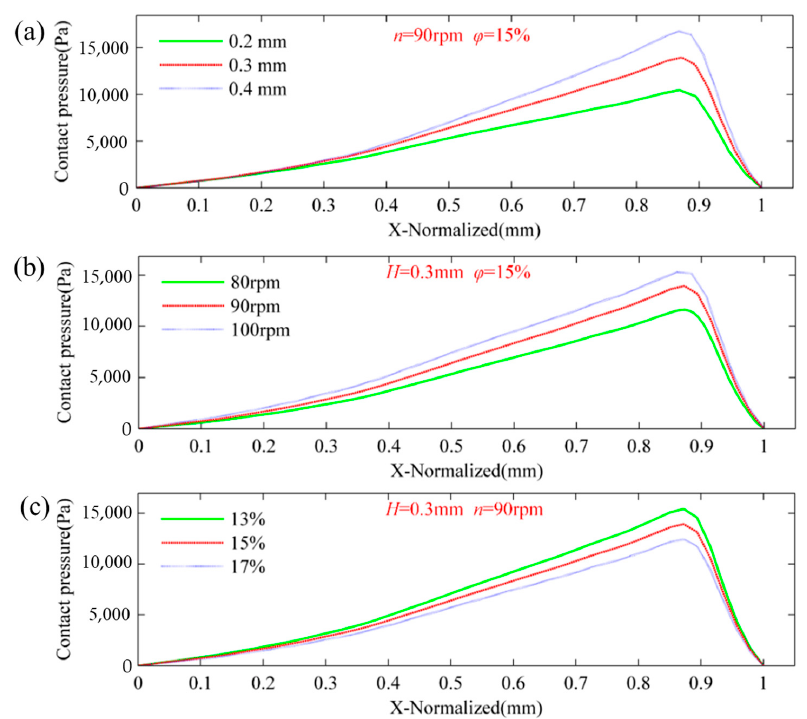
Figure 14. The in fl uence curve of di ff erent process parameters on contact pressure. ( a ) Immersion Figure 14. The influence curve of different process parameters on contact pressure. ( a ) Immersion depth; ( b ) rotation speed; ( c ) water content. depth; ( b ) rotation speed; ( c ) water